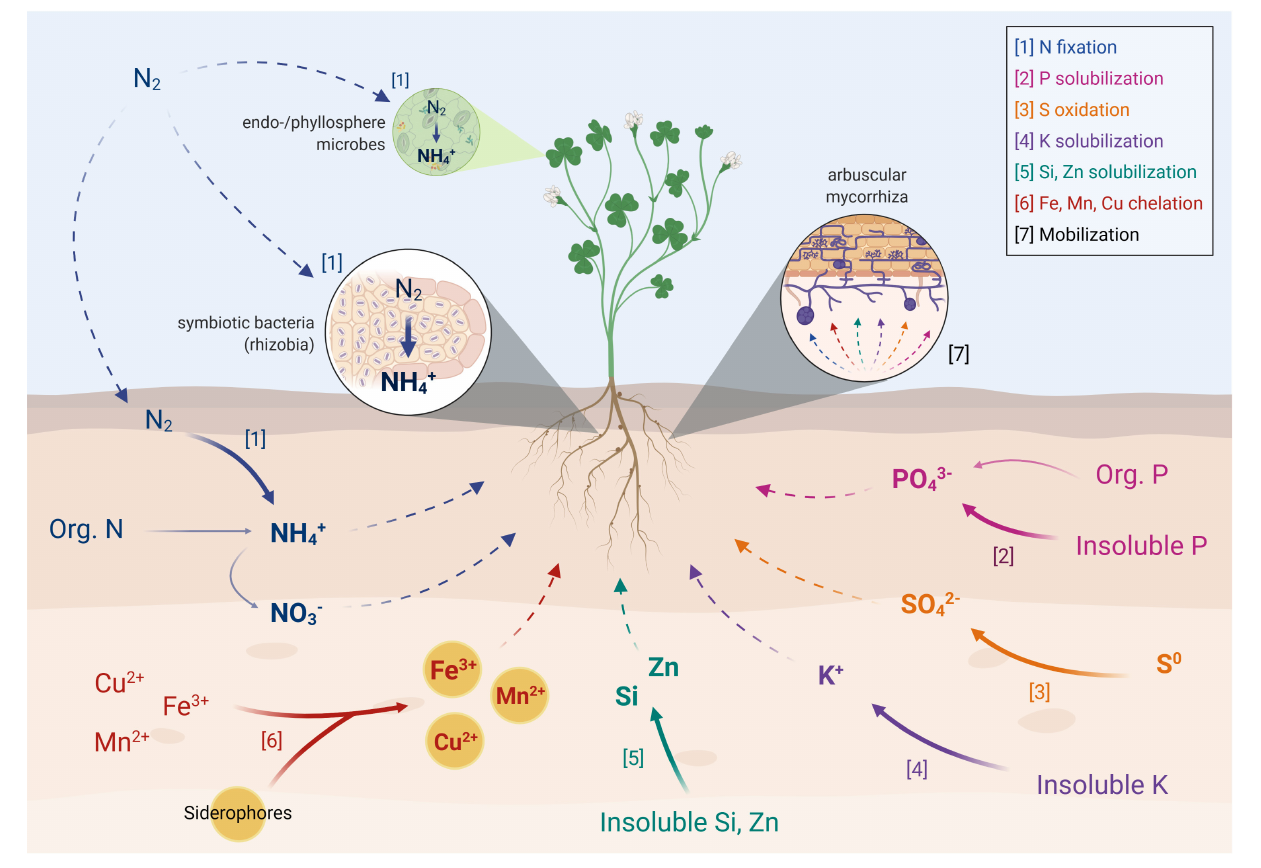
FIGURE 1 | Key microbially-mediated nutrient transformation/acquisition pathways associated with biofertilizers. Full arrows represent microbial transformations whereas dashed arrows represent mobilization/movement of nutrients. Created with BioRender